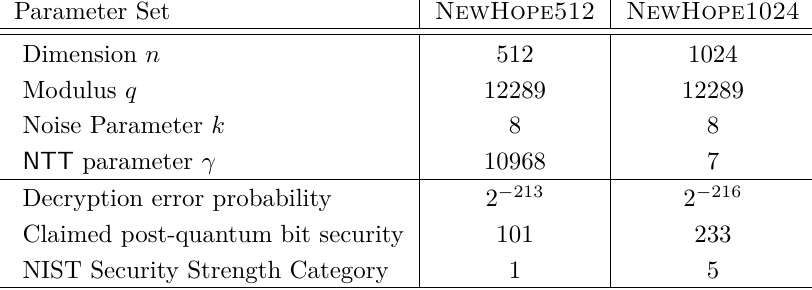
Table 1: Parameters of NewHope512 and NewHope1024 and derived high-level properties [AAB +